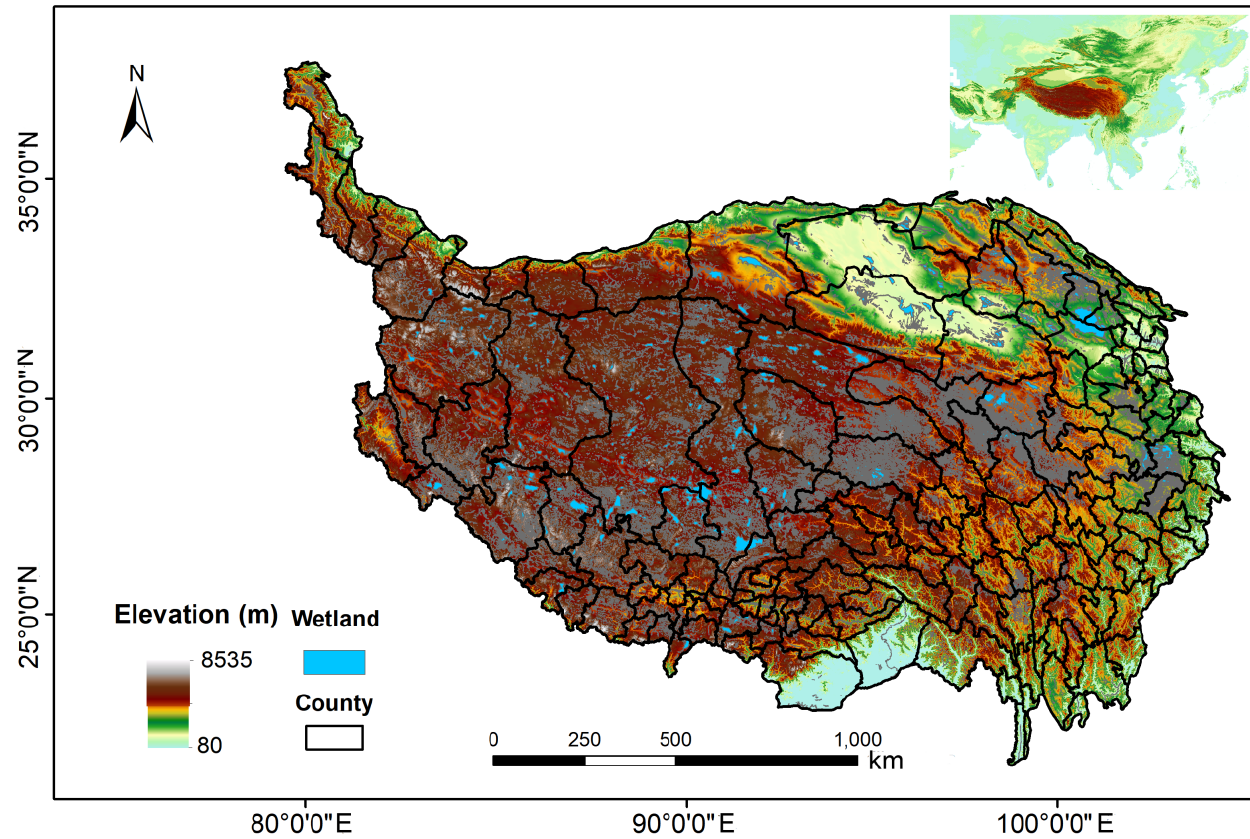
Figure 1. wetland distribution map of Qinghai-Tibet Plateau. Figure 1. Wetland distribution map of Qinghai-Tibet